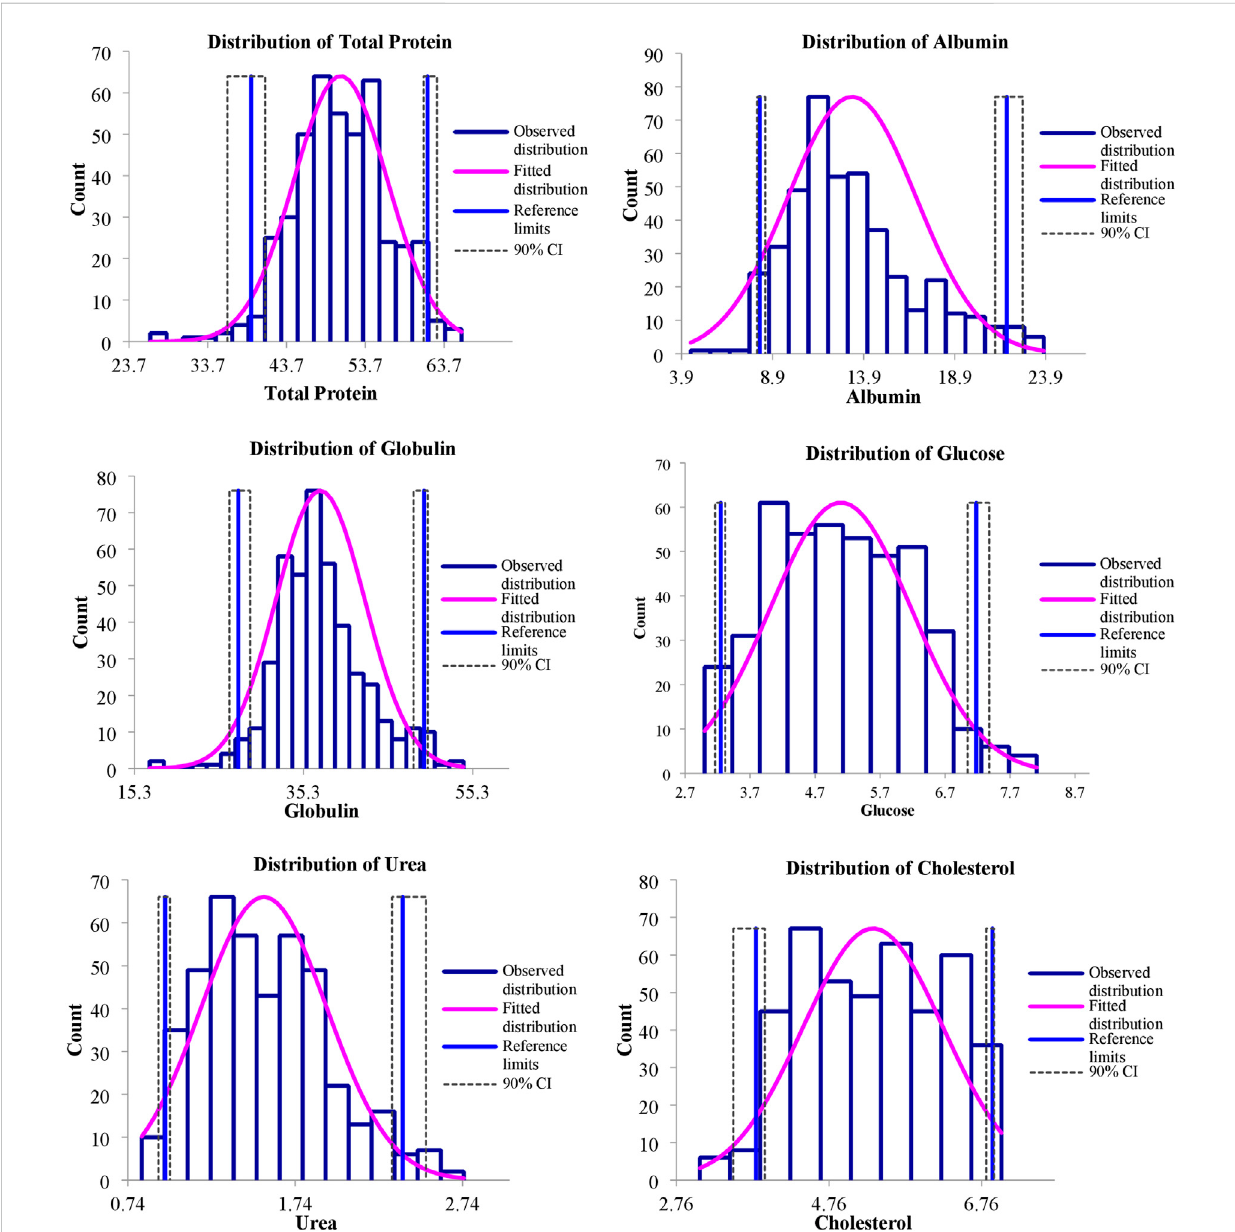
FIGURE 3 Representing distribution of serum biochemical reference intervals of S. esocinus from River Jhelum.